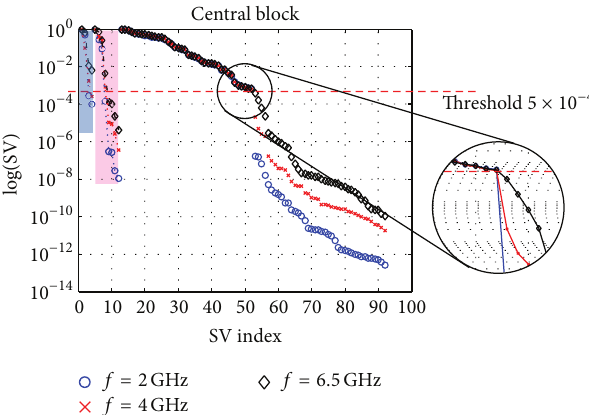
Figure 2: Distribution of the singular values for different frequen- cies for the single central